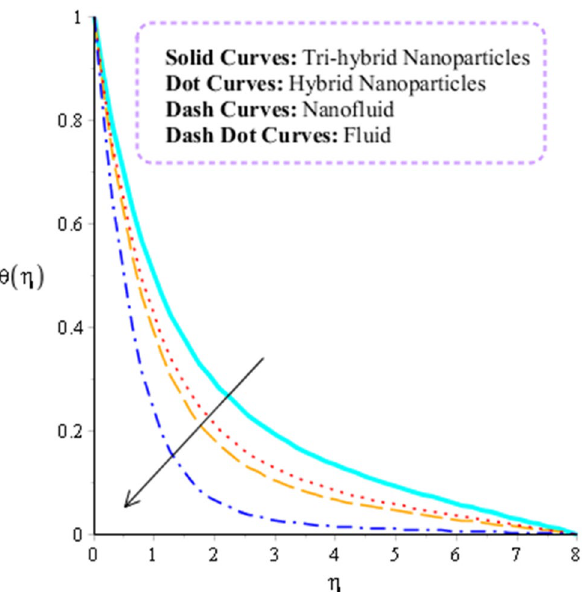
Figure 11. Comparison heat energy performance for tri-hybrid nanoparticles, nanofluid and fluid and hybrid